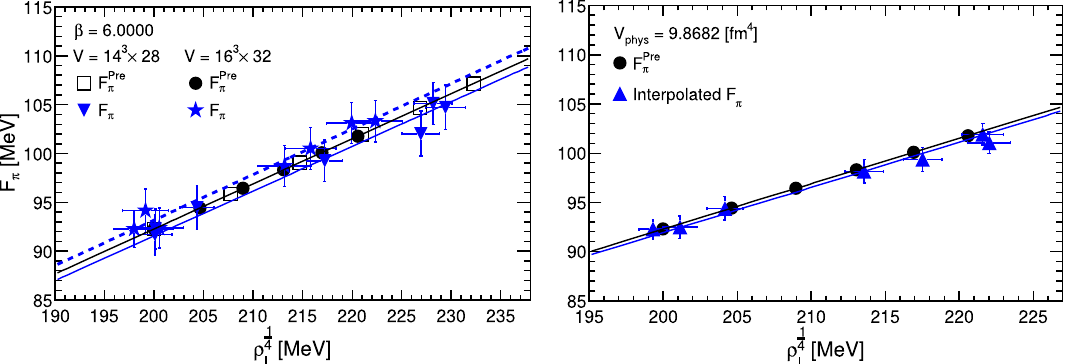
line indicate the fitting results of the predictions, the numerical results of V = 14 3 × 28, and V = 16 3 × 32, respectively. In the right figure, the black full line and the red full line indicate the fitting results of the prediction and the interpolated results, respectively